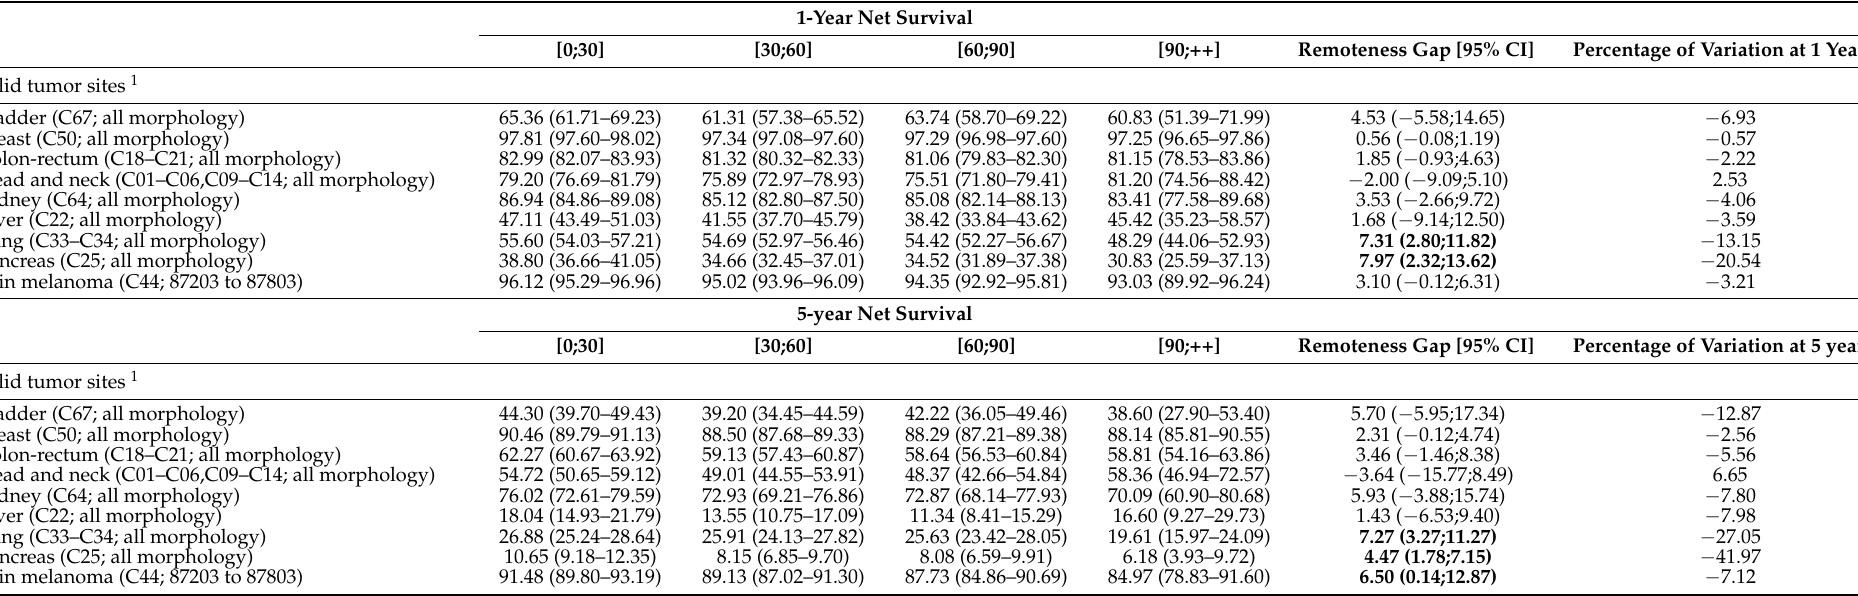
Table 3. One and five-year net survival probabilities and 95% confidence intervals and remoteness gap (RGap), by cancer site, in